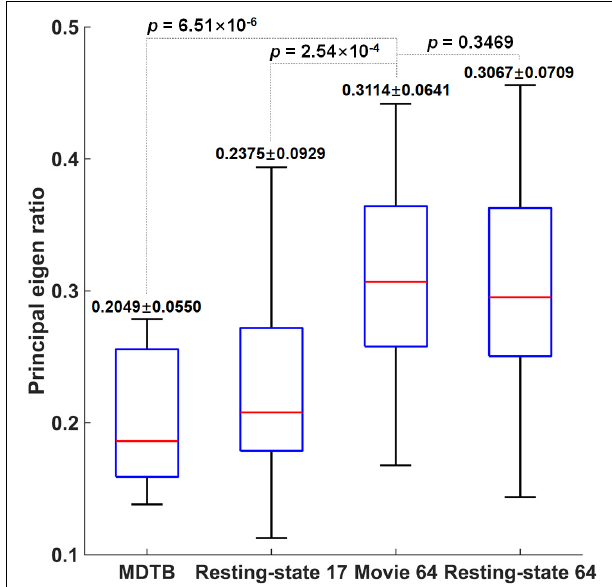
FIGURE 3 | The comparison of functional homogeneity measured by the principal eigen ratio.